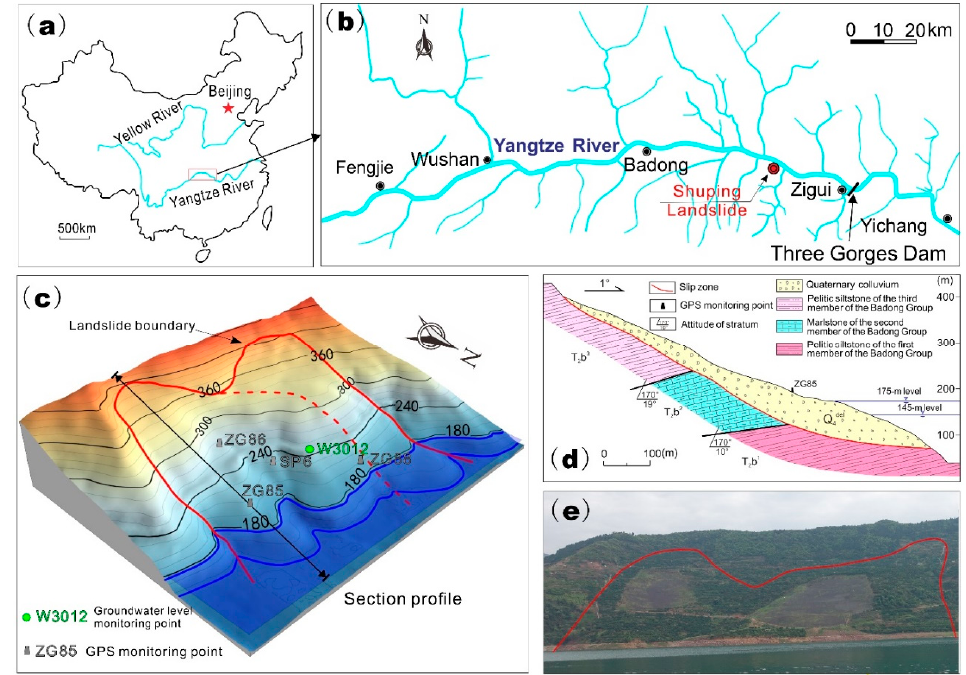
Figure 2. The location of the Shuping landslide ( a,b ). Plain view ( c ), with GPS monitoring points ZG85, ZG86, ZG88, SP6 and underground monitoring point W3012, and profile section ( d ) of the Shuping landslide. Full view of the Shuping landslide from the Yangtze River ( e ).